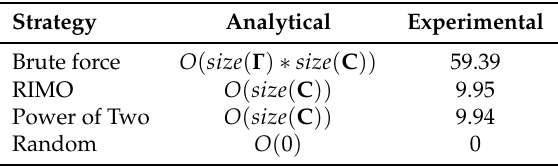
Table 1. Message overhead per selection